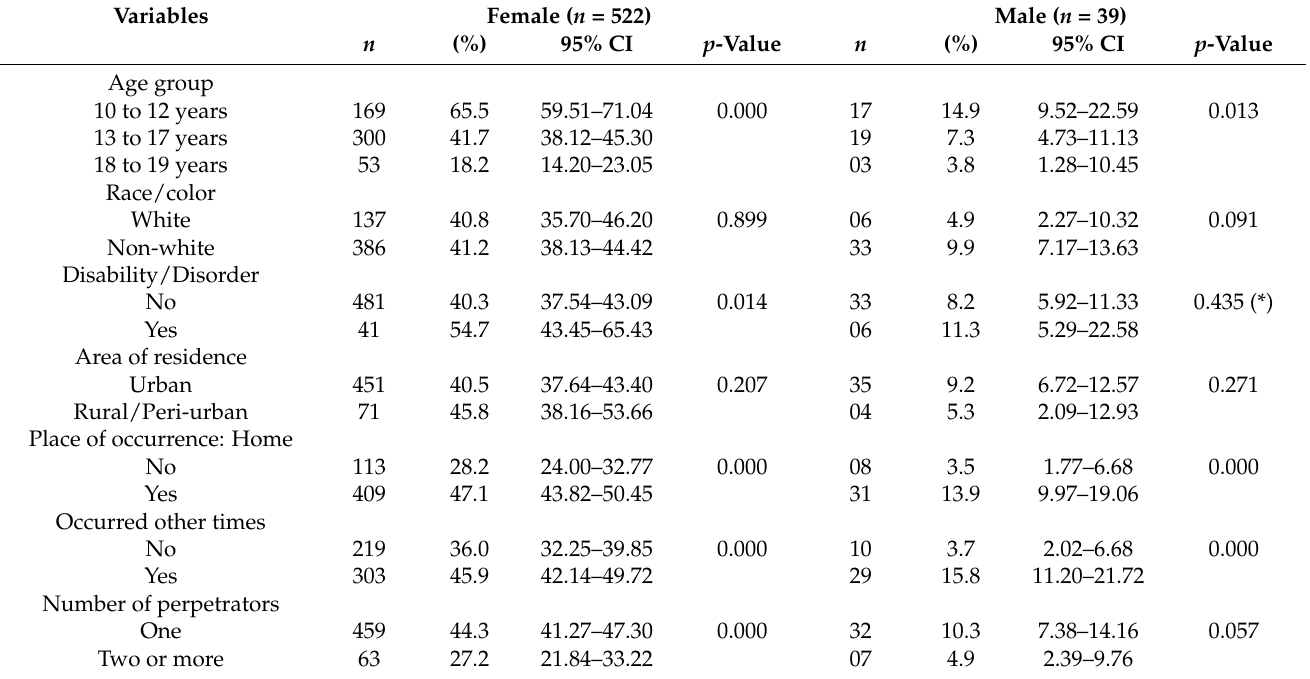
Table 2. Distribution of the characteristics of the reports of sexual violence among adolescents by sex Esp í rito Santo, Brazil, 2011 to 2018 ( n =